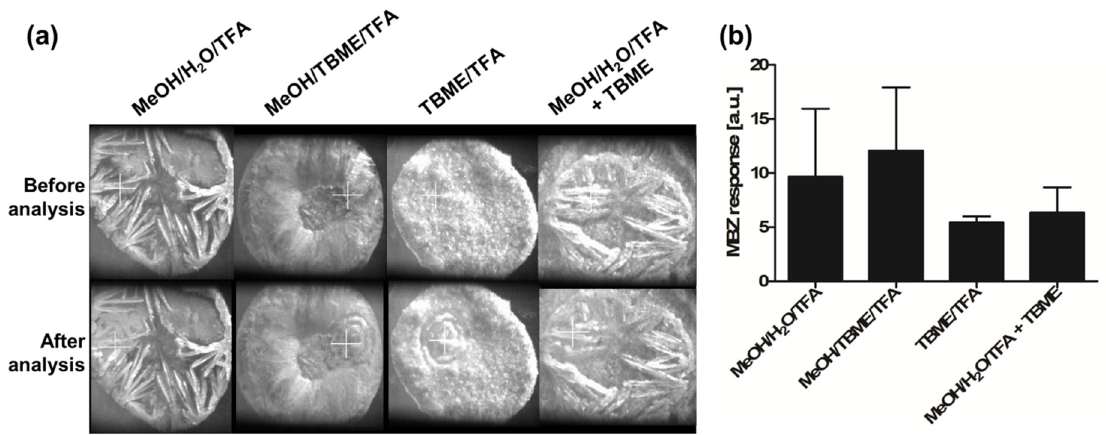
Figure 4. ( a ) Crystal morphology of 2,5-dihydroxybenzoic acid (2,5-DHB) in MeOH/H 2 O/trifluoroacetic acid (TFA) 50:50:0.1 ( v / v / v ), MeOH/tert-butyl methyl ether (TBME)/TFA 50:50:0.1 ( v / v / v ), TBME/TFA 100:0.1 ( v / v ), and MeOH/H 2 O/TFA 50:50:0.1 ( v / v / v ) followed by resolubilization in TBME on tissue. ( b ) Histogram showing the mebendazole (MBZ) response from dosed tissues and the variability between replicates, depending on the 2,5-DHB solvent composition. Triplicates were used for these analyses, and error bars represent the standard deviation. Table 3. Results for the creation of the calibration curve for the quantification of mebendazole (MBZ) in tissue sections using 2,5-dihydroxybenzoic acid (2,5-DHB) in tert-butyl methyl